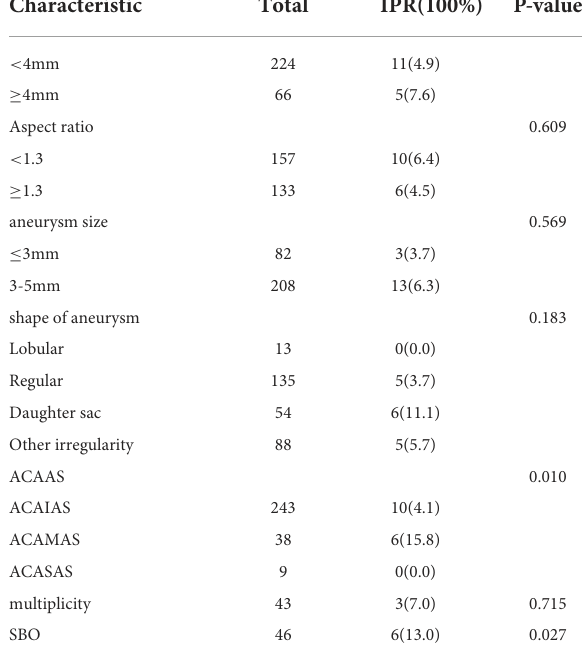
TABLE 1 Baseline characteristics of patients and aneurysms in IPR and non-IPR